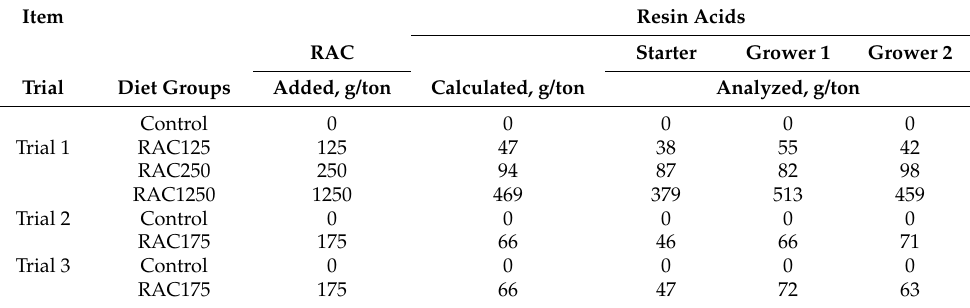
Table 3. Added test ingredient (RAC) and calculated and analyzed values of resin acids in experi- mental